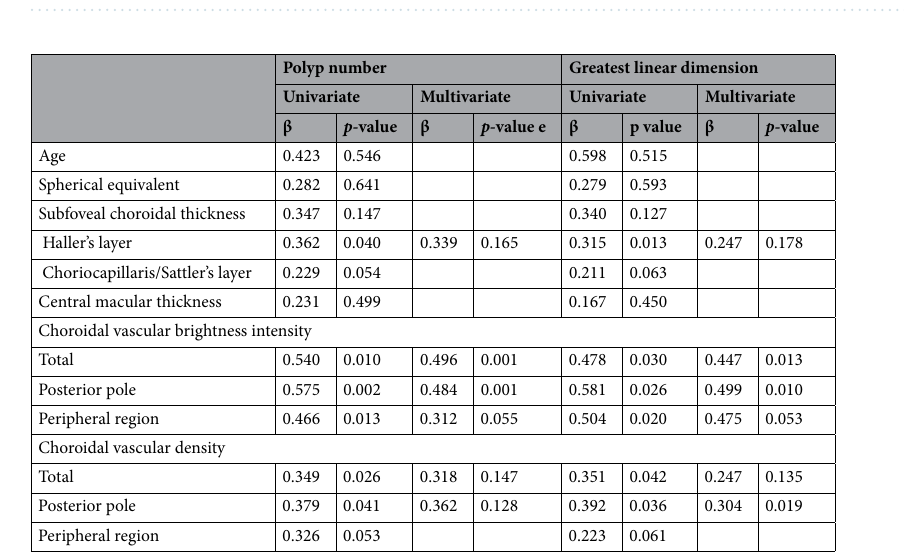
Figure 2. Scatter plot showing correlation between greatest linear dimension and choroidal vascular features.